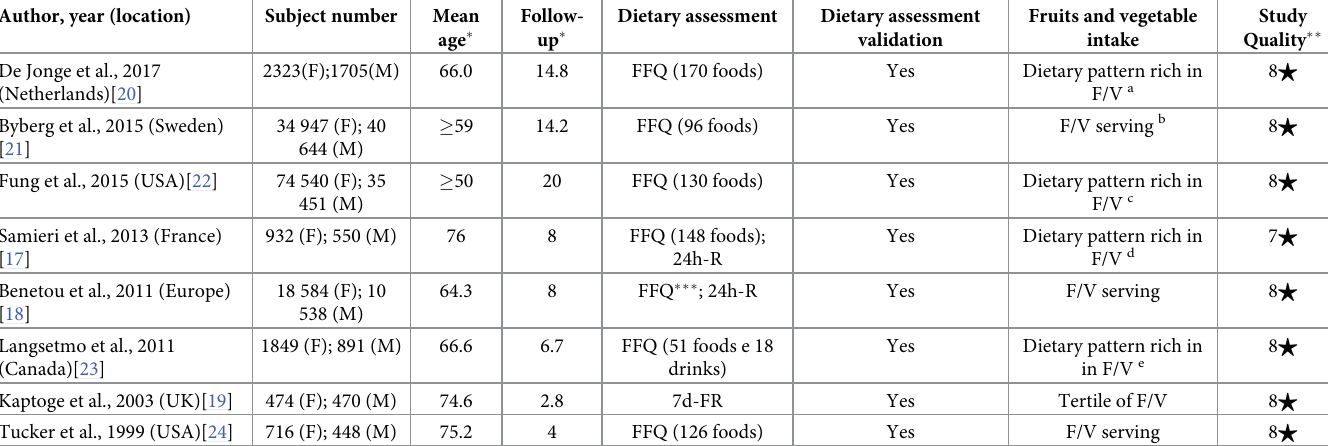
Table 1. Characteristics of the cohort studies included in the systematic